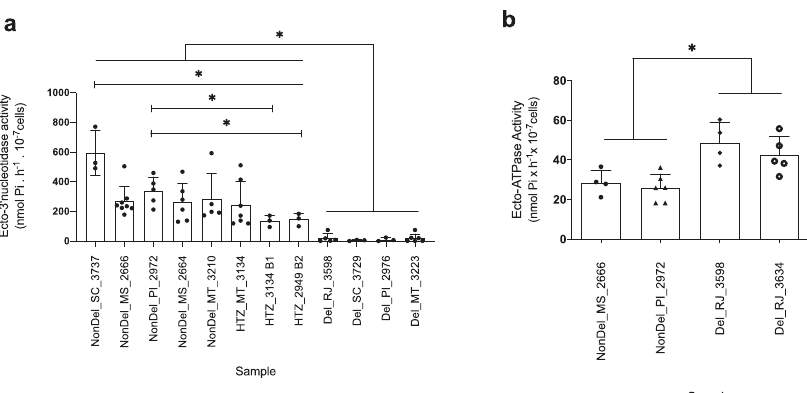
Fig. 6 Ecto-3 ’ -nucleotidase and ecto-ATPase activity correlates to read-depth pro fi les on chr31. a Ecto-3 ′ -nucleotidase activity was quanti fi ed by measuring the rate of inorganic phosphate ( Pi ) release during adenosine 3 ’ -AMP hydrolysis as described in Freitas-Mesquita et al. 28 . Bar plots show mean and S.E. for at least three replicate assays ( n = 3 independent experiments). Welch ’ s t -test was applied to test for statistical signi fi cance between pairs of samples at *p < 0.05. Results indicate a signi fi cant reduction of enzymatic activity in Del isolates relative to all NonDel and HTZ isolates. Activity appears signi fi cantly higher in NonDel_SC_3737 than in other NonDel and HTZ samples. Activity also appears signi fi cantly higher in NonDel_PI_2972 relative to HTZ_3134_B1 and HTZ_2949_B2 subcultures. b Ecto-ATPase activity was quanti fi ed with the same protocol except replacing 3 ’ -AMP with equimolar ATP and Mg 2 + . T -tests between NonDel and Del isolates suggest higher ecto-ATPase activity in Del isolates than in all NonDel isolates, but larger samples sizes are required to substantiate the